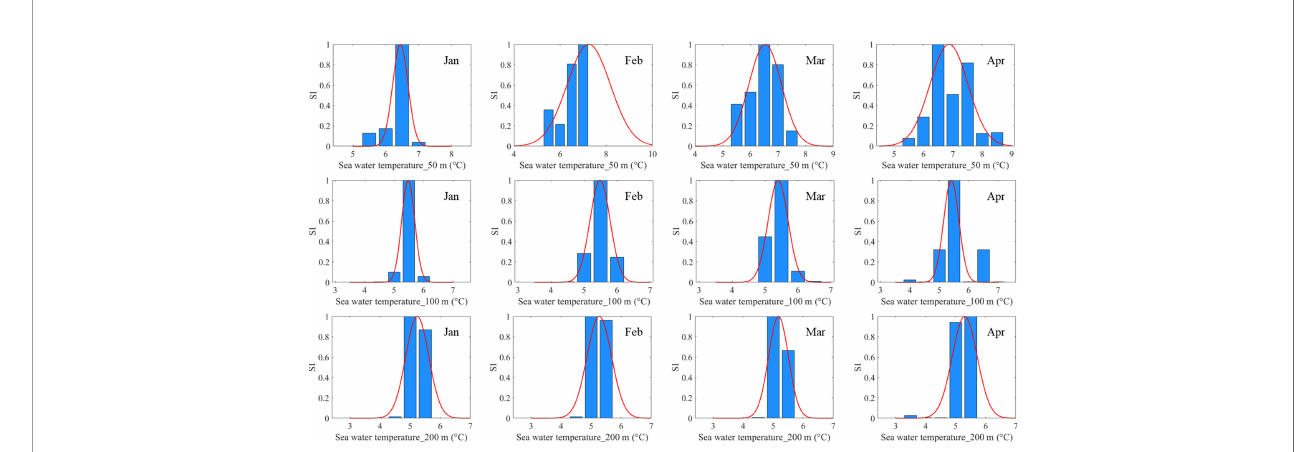
FIGURE 1 | Fitted SI curves of water temperature at different depths from January to